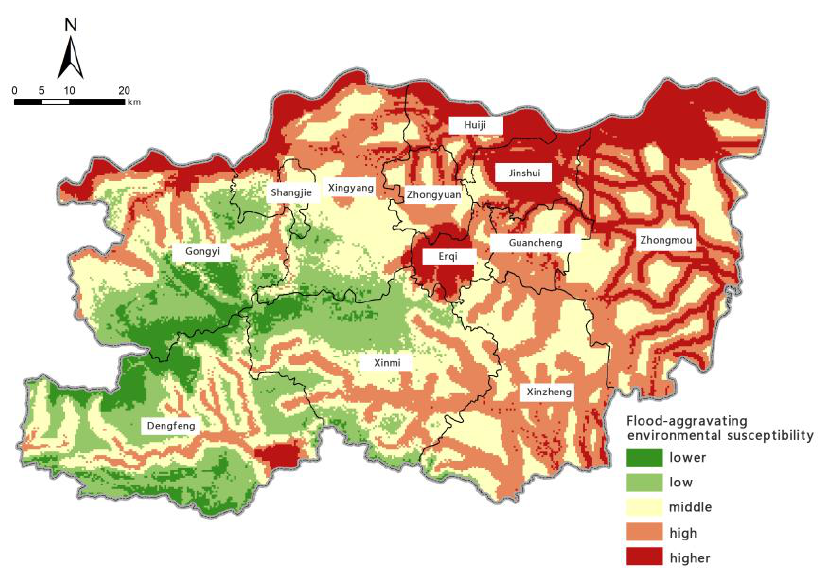
Figure 6. Zoning map of flood-aggravating environmental susceptibility.